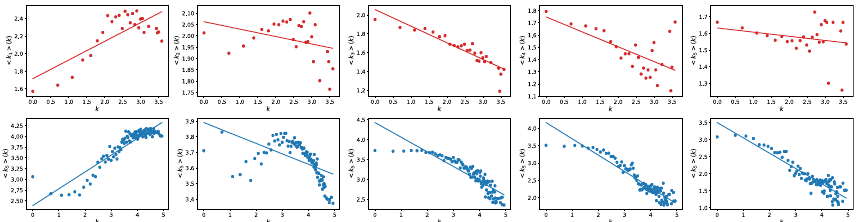
Fig. 20 Degree correlations of a fractal (top row) and a non‑fractal (bottom row) brain network at distances from 1 to 5. (cid:31) k m (cid:30) ( k ) is plotted against k on a log‑log scale, and the line fitted to the log‑transformed data is also